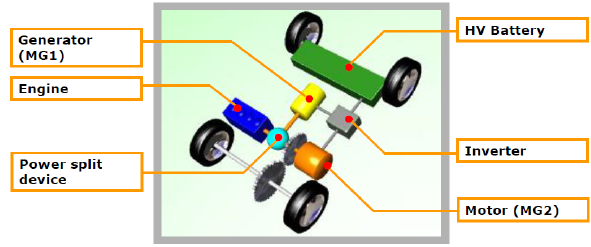
Figure 8. The components of the Prius Hybrid. Source [35].